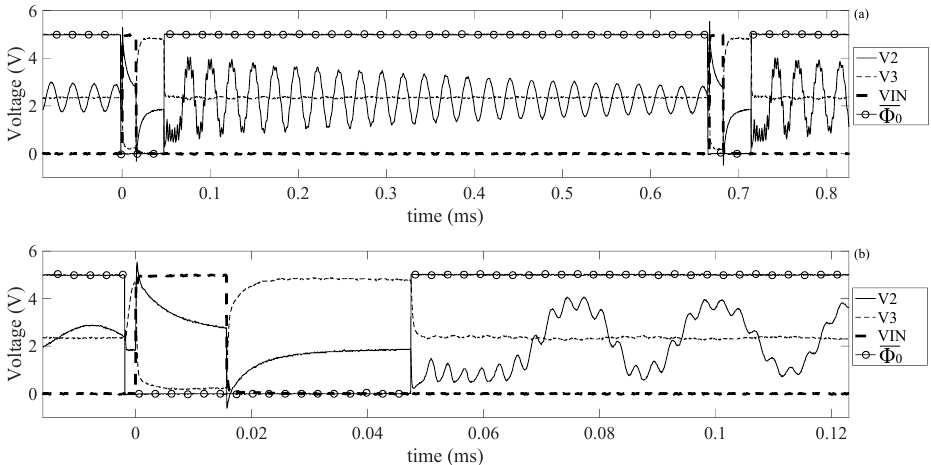
Figure 26. Whole read-out cycle driving a BvD load and using C C 2 = 560 pF. ( a ) analysis of the main signals in a whole cycle; ( b ) analysis of the main signals in actuation mode.